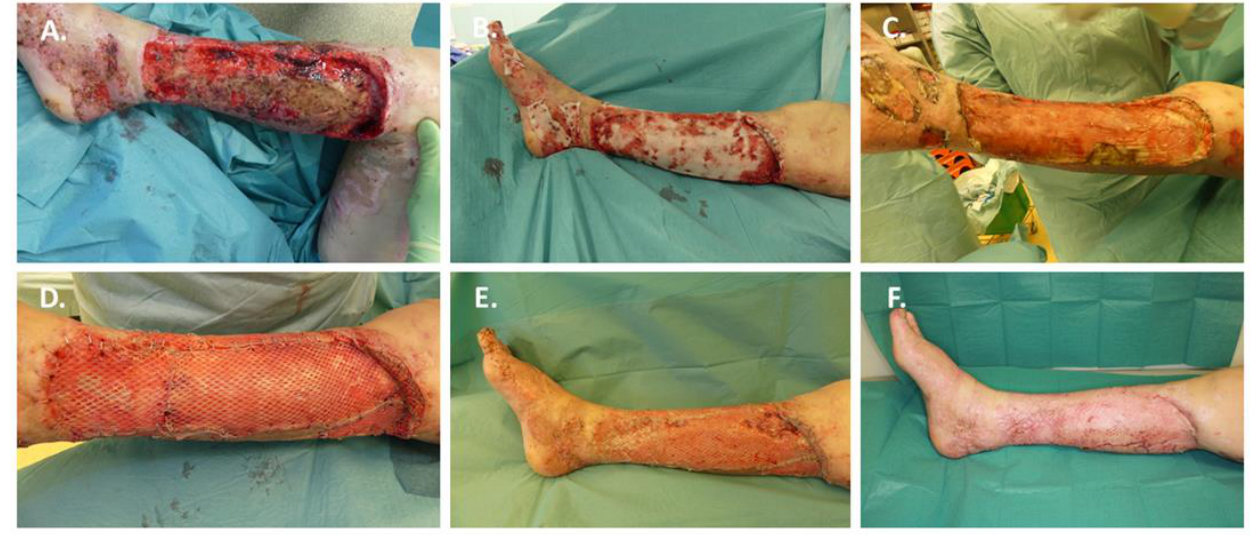
Figure 6. A case of superinfected and non-healing wounds after burn treated with BTM. A 69-year-old female was admitted primarily for the care of extensive lower extremity burn injuries bilaterally. A total of 15% of the total body surface area was burned 2a-3°. ( A ) Wound situation with recurrent wound infections with multi-resistant Pseudomonas aeruginosa ; ( B ) Wound situation after renewed hydrosurgical wound debridement using VERSAJET and application of BTM and phages for targeted therapy; ( C ) Integration of BTM after 21 days; ( D ) Definitive defect coverage with autologous split-thickness skin grafting; ( E ) Complete healing of autologous skin grafts; ( F ) 1-month follow-up.